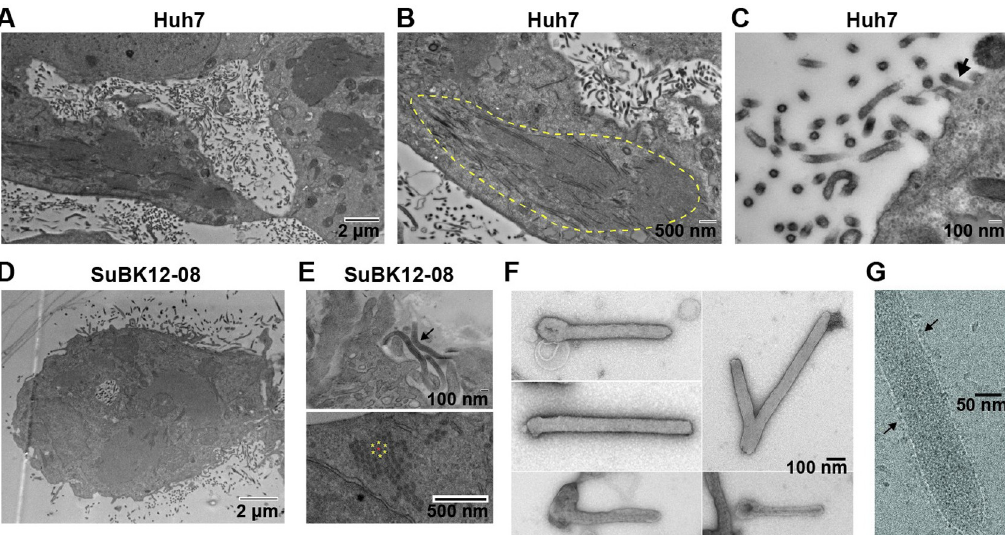
Fig 3. Electron microscopy (EM) of rLLOV comp -infected cells and virions. (A-E) Transmission EM of Huh7 or SuBK12-08 cells infected with rLLOV-IR ins -MARV UTR+tr at an MOI of 1 and fixed at 3 dpi. (A) Release of viral particles from infected Huh7 cells. (B) Circled area indicates the accumulation of filamentous LLOV nucleocapsids into inclusions. (C) Mature virions budding from the cell surface (arrow). (D) rLLOV comp -infected SuBK12-08 cell releasing viral particles. (E) Filamentous viral particles (top panel, arrow) and cross section of viral inclusions (bottom panel). The asterisks indicate the typical honeycomb pattern of filovirus nucleocapsids within the rLLOV comp inclusions. (F) EM of negatively stained, isolated rLLOV-IR ins - MARV UTR+tr virions. (G) CryoEM of rLLOV-IR ins -MARV UTR+tr virions. LLOV glycoproteins studding the particle surface are indicated with